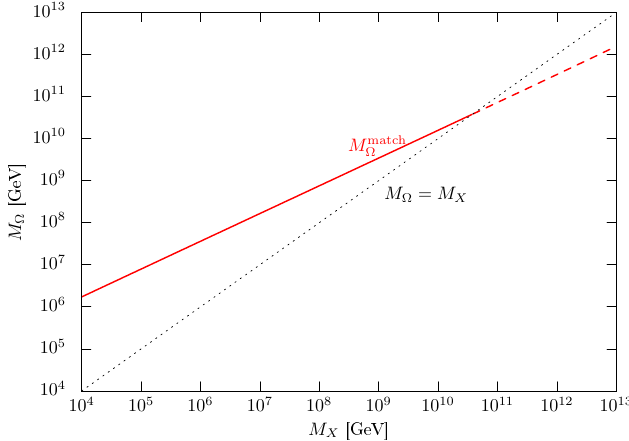
Figure 4. The matching scale M match